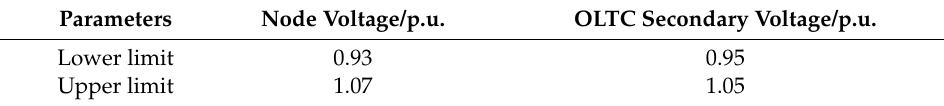
Table 5. OLTC parameters.